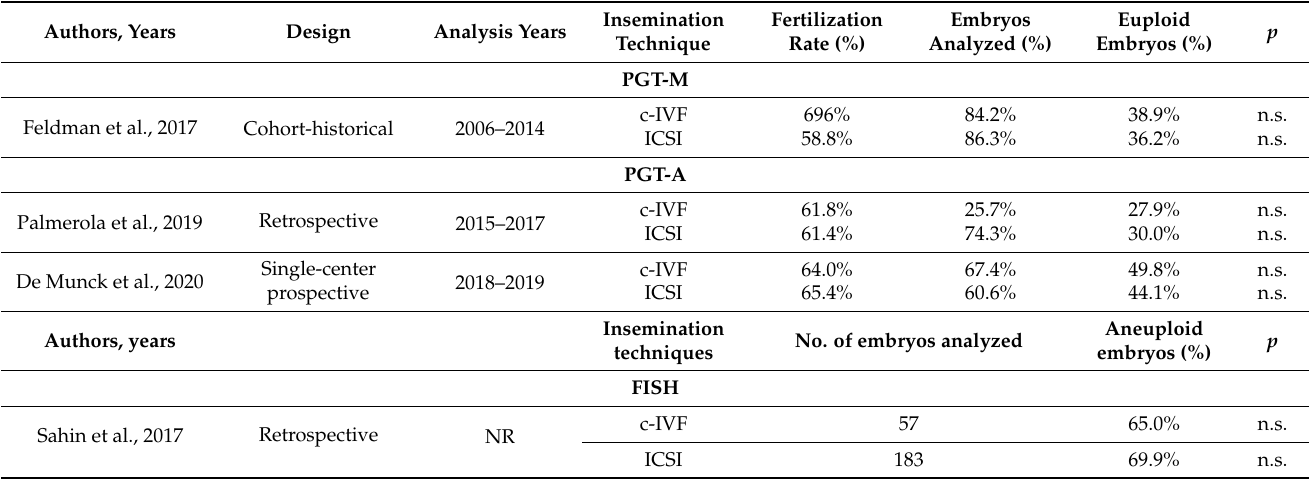
Table 4. Results deriving from the comparison of conventional IVF vs. ICSI for PGT-M, PGT-A and FISH